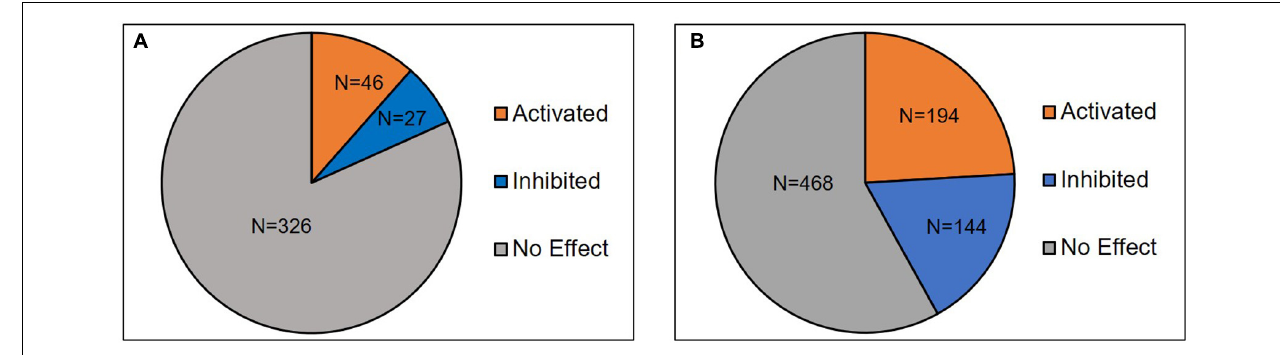
TABLE 1 | Transcription regulators activated in sperm after antioxidant therapy.